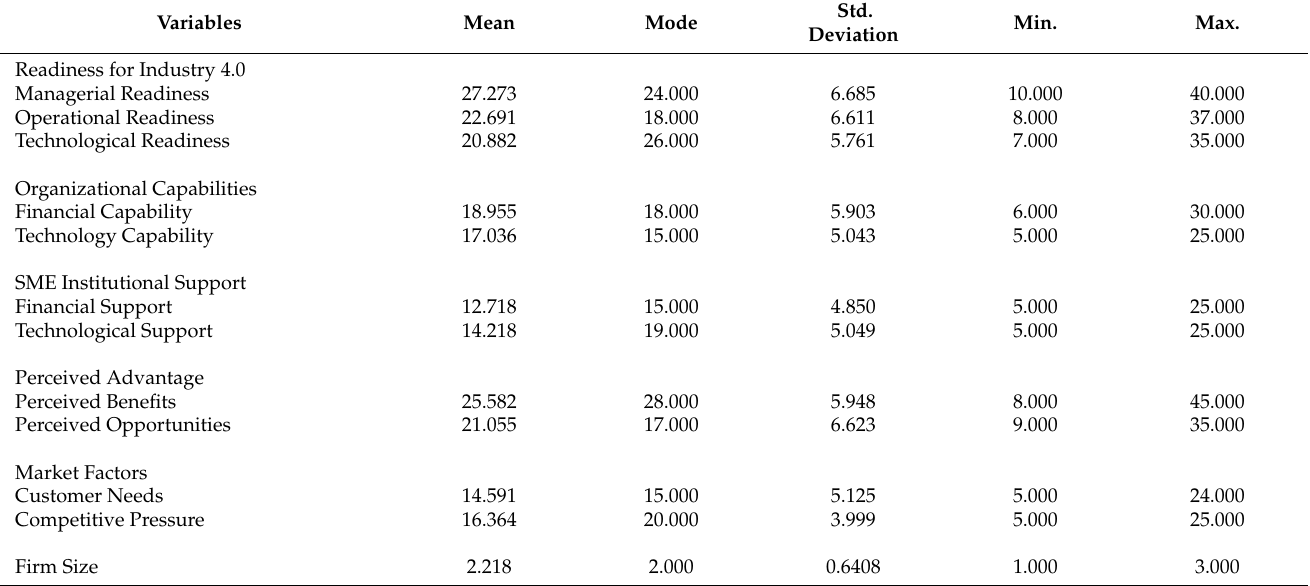
Table 8. Mean and standard deviation of